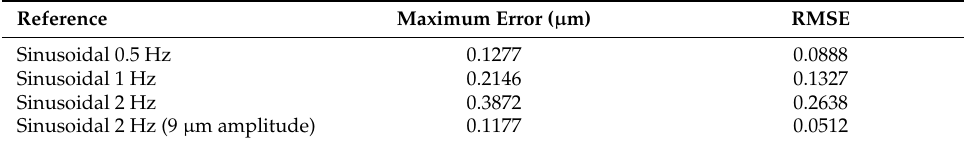
Figure 27. Error of tracking of the MPC for a 2 Hz sinusoidal reference of reduced amplitude. Table 6. Tracking error for sinusoidal reference far from trained frecuency.